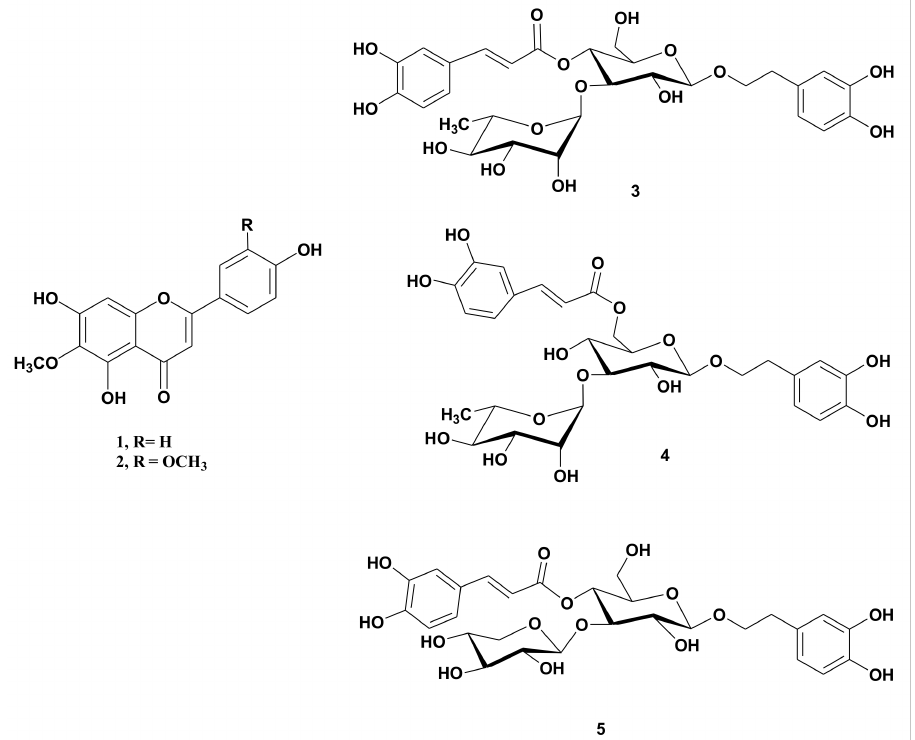
Figure 1. Chemical structures of the isolated compounds ( 1 – 5 ) from N. oppositifolia